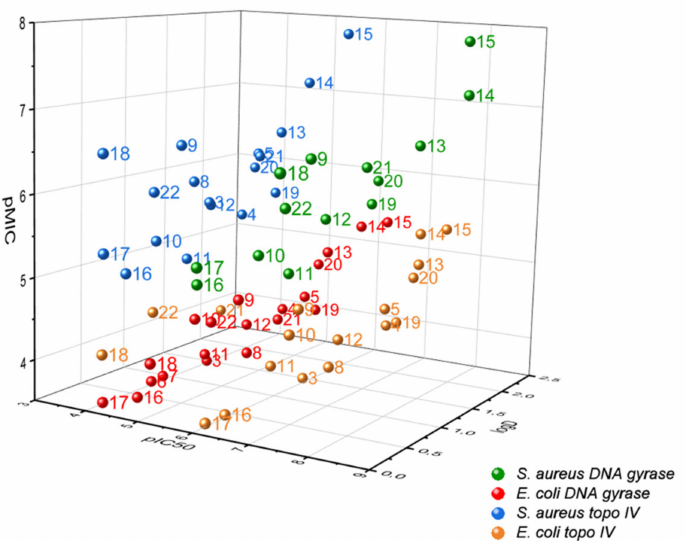
Figure 6. 3D plot representing influence of the calculated logD (pH = 7.4) on pIC 50 and pMIC against all antibacterial targets. The graph clearly indicates that increasing lipophilicity increases enzymatic activity (IC 50 ) and antibacterial potency